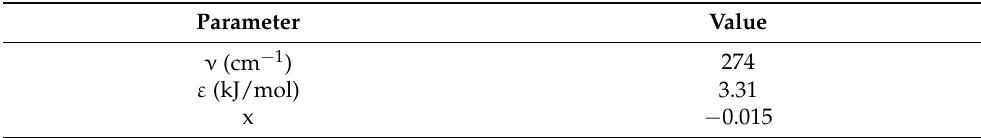
Table 4. Values of SET’s model